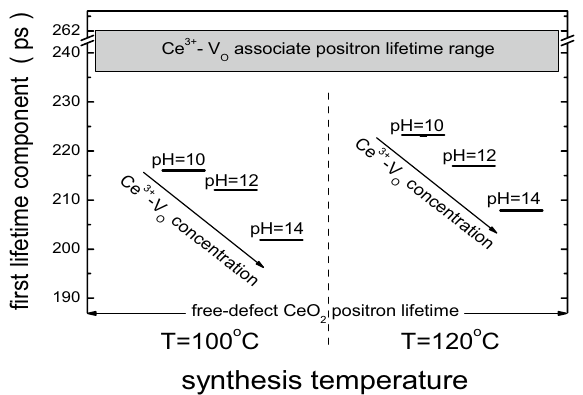
Figure 7. Schematic representation of the τ 1 evolution as a function of reaction pH for the different synthesis temperatures. The corresponding lifetimes for the free-defect CeO 2 and the Ce 3+ -oxygen vacancy associates are also